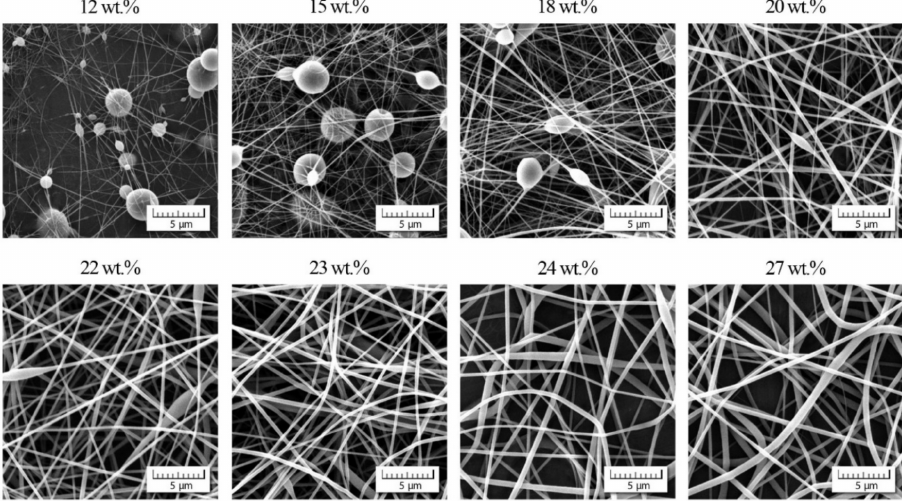
Figure 3. Morphology of individual nanofibers in dependence on PVDF- co -HFP concentration.